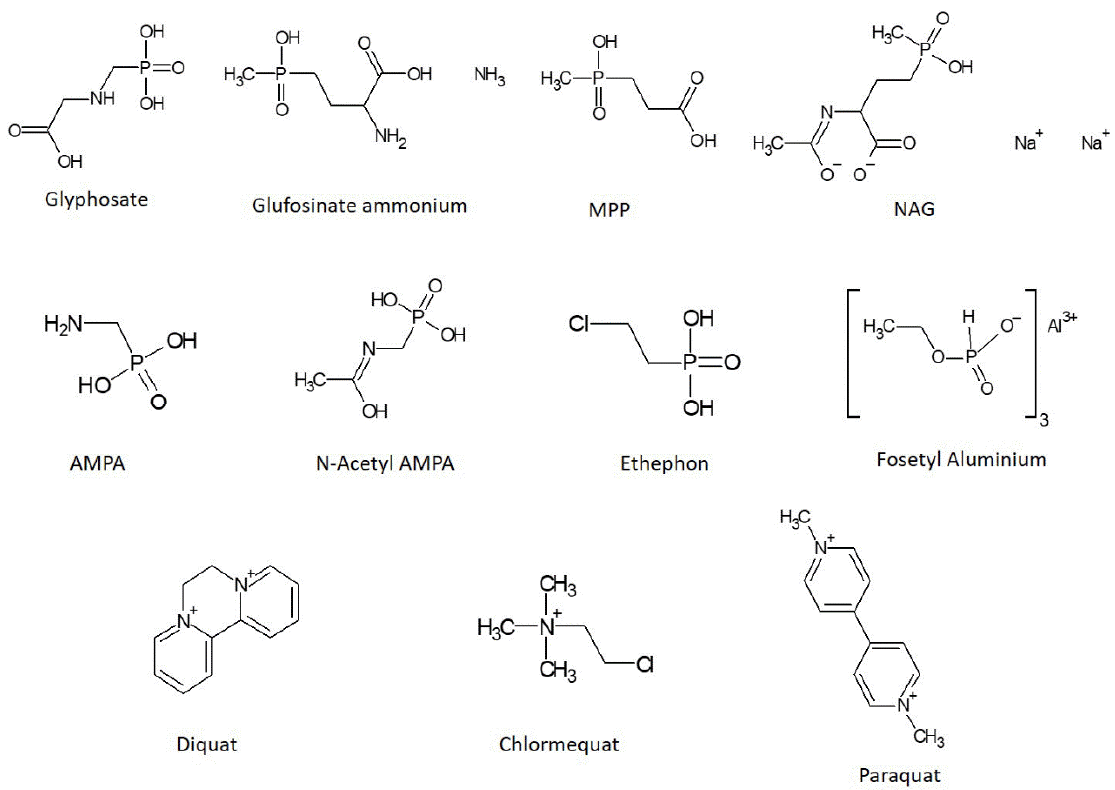
Figure 1. Chemical structures of glyphosate, glufosinate ammonium, [3[hydroxy(methyl)phos- phinoyl]propionic acid (MPP), N-acetyl-glufosinate (NAG), aminomethylphosphonic acid (AMPA), N-acetyl-AMPA, fosetyl aluminum, ethephon, diquat, chlormequat and paraquat.